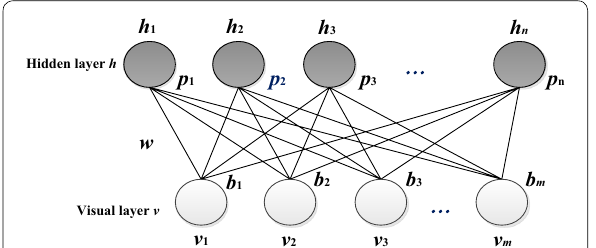
Figure 5 Architecture of restricted Boltzmann machine (RBM)